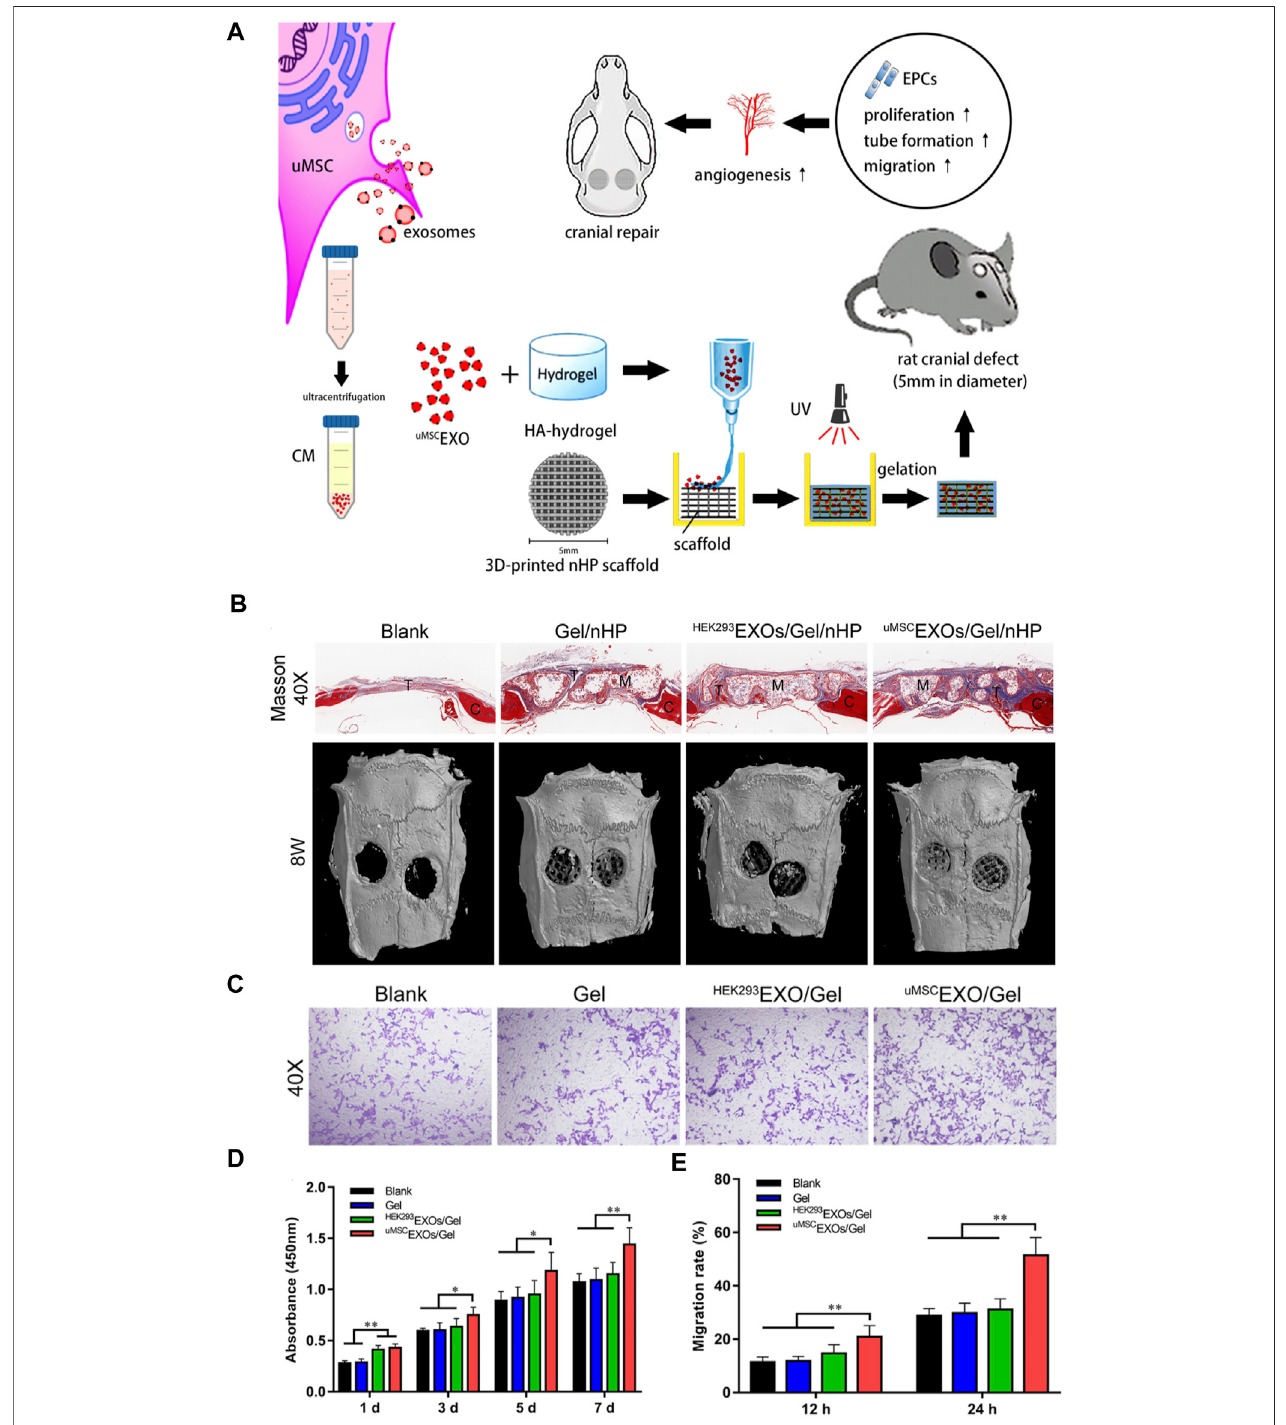
FIGURE 7 | Schematic diagram of uMSC EXOs combined with HA-Gel and nHP scaffolds to promote the repair of skull defects. (A) Hydrogel composite exosomes scaffoldpromotesangiogenesistorepaircriticalsizeskulldefectsinrats. (B) Themicro-CT scanimageand quantitative analysisoftheMasson ’ strichrome(40×)image after 8 weeks of repairing the critical size skull defect in vivo in the rat, showing the skull defect area. (C) Transwell migration analysis of endothelial progenitor cells in differenttreatments. (D) CCK-8showsthat uMSC EXOscanpromoteEPCsproliferation. (E) Quantitativeanalysisofthemigrationrate(Zhangetal.,2021).Copyright 2021, American Chemical